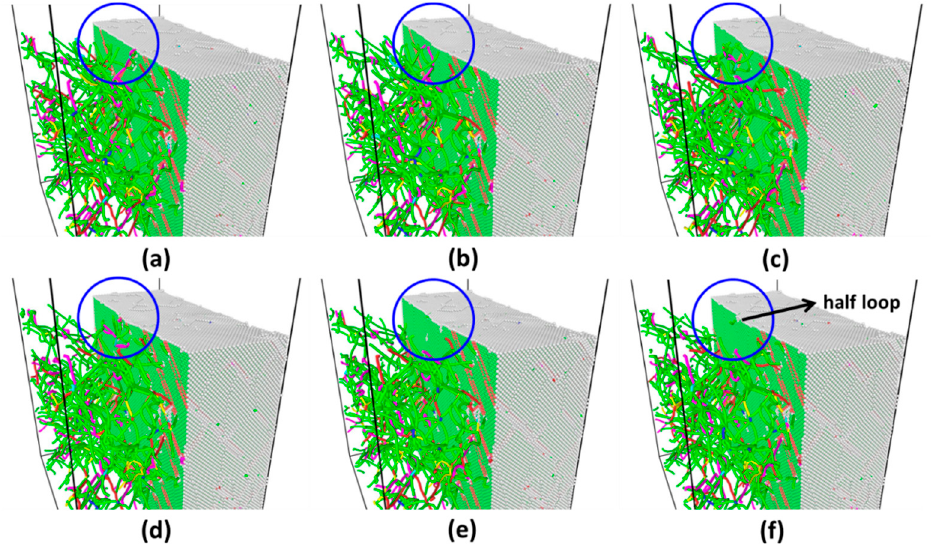
Figure 13. Snapshots of atomic structure and distributions of dislocations across sample under strain 0.14. ( a – f ) are corresponding to red circles marked in Figure 12a. Pre-existing dislocations are driven away due to stress field induced by the tip (illustrated by the blue circles). ( e ) Shows a half loop nucleated under tip.